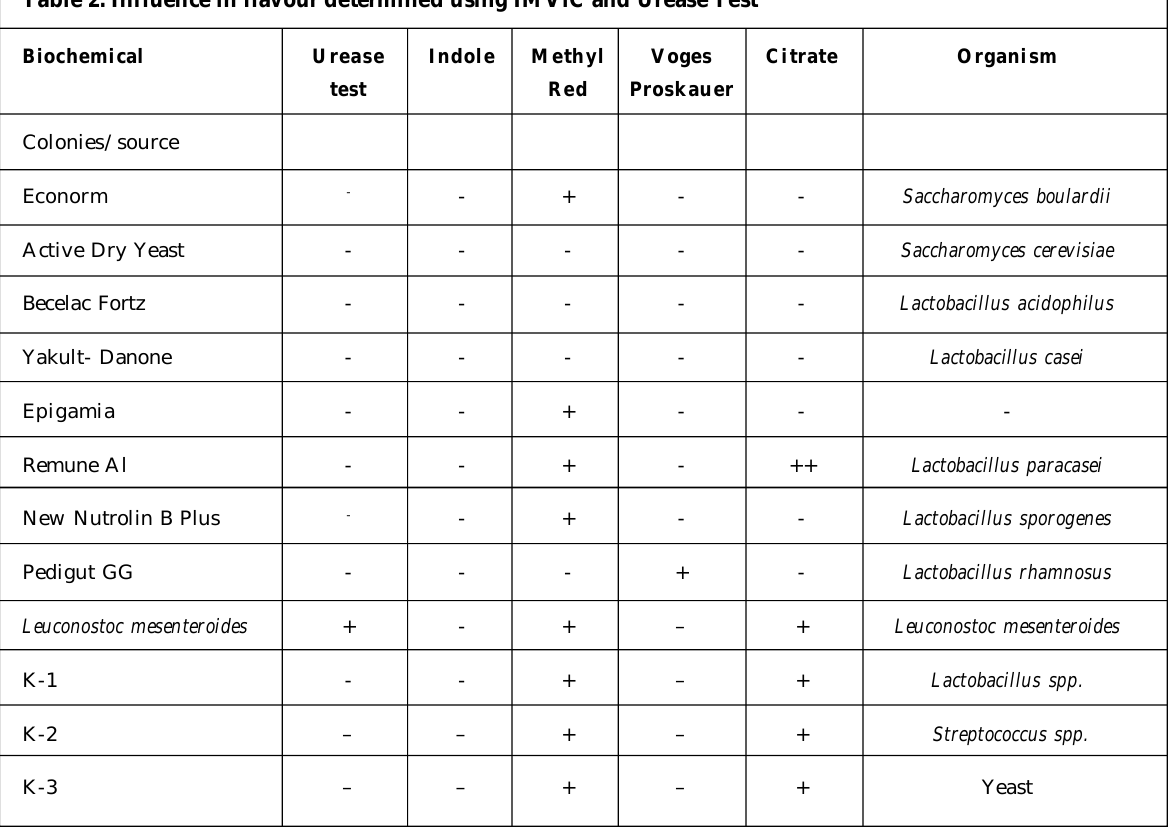
Table 2: Influence in flavour determined using IMViC and Urease